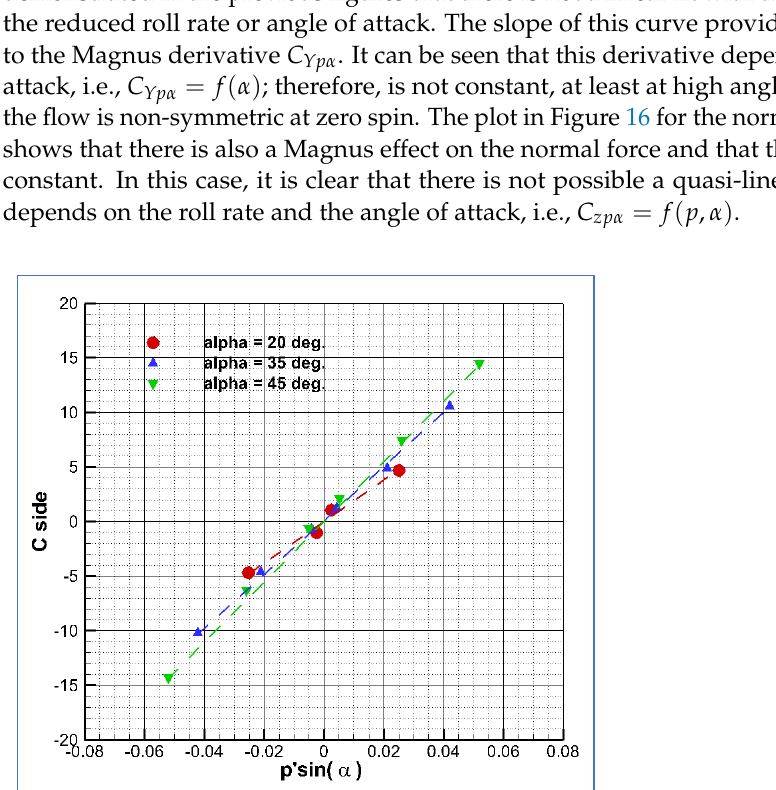
Figure 15. Side force coefficient versus reduced roll rate and angle of attack. Ma = 0.2, Re =2 × 10 6 and three angles of attack.